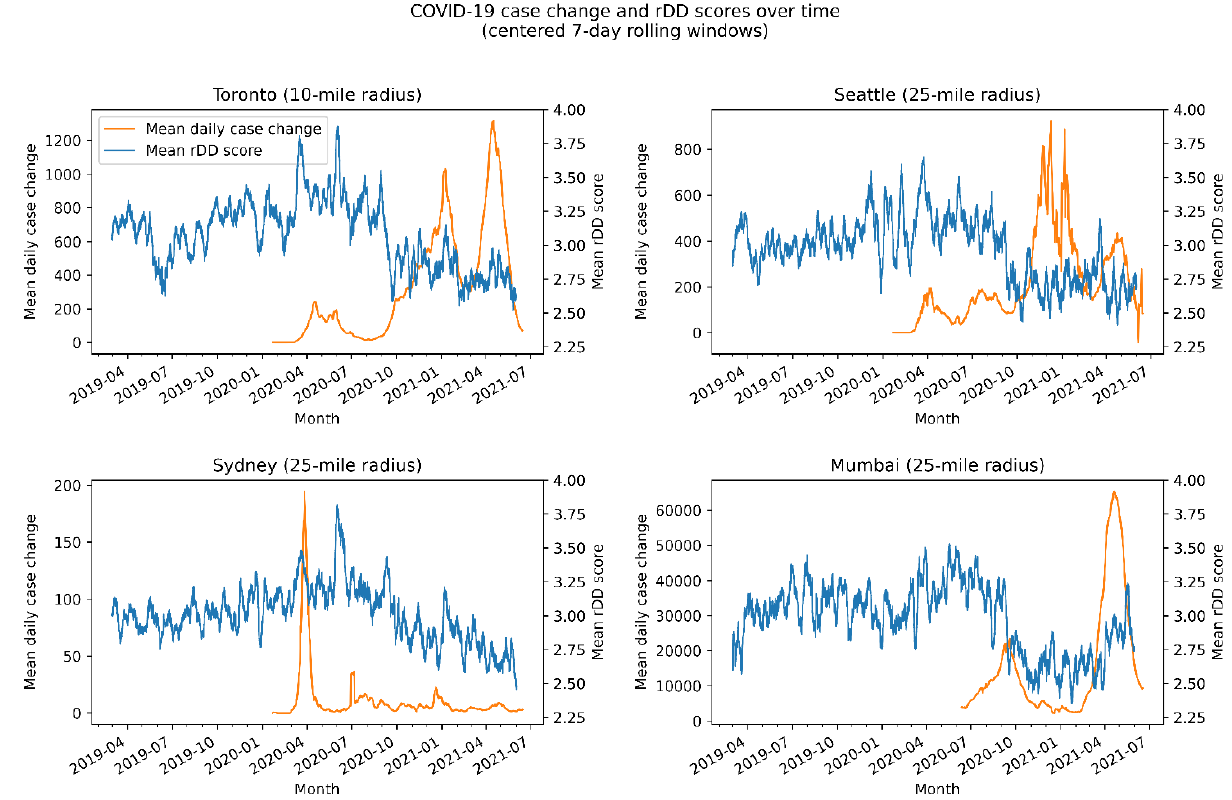
Figure 3: Region case counts (centered 7-day window mean daily change) in orange and rDD scores (centered 7-day window mean) in blue for the Twitter